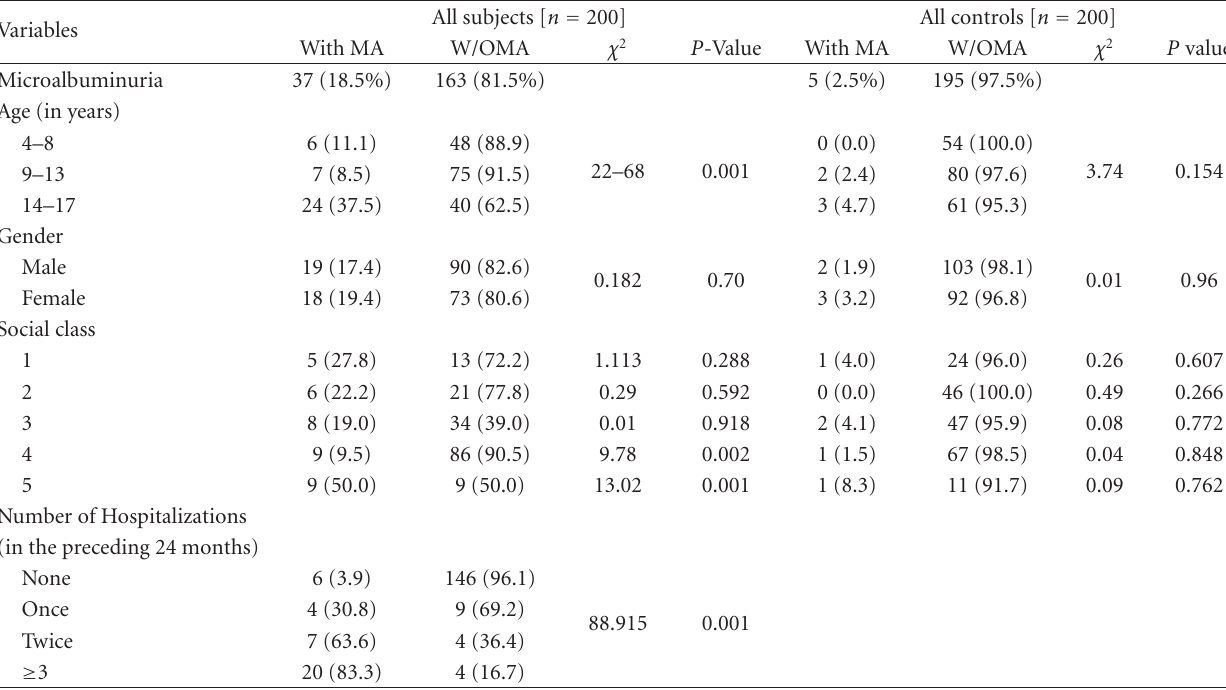
Table 2: Age, gender, social class, and number of hospitalizations of subjects and controls with and without